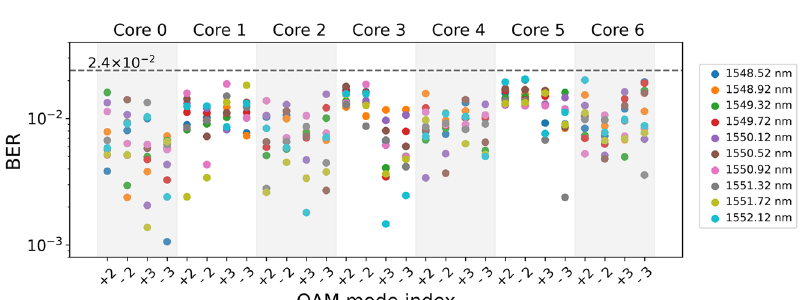
Figure 10: Measured BER of all 560 channels after 60 km transmission.